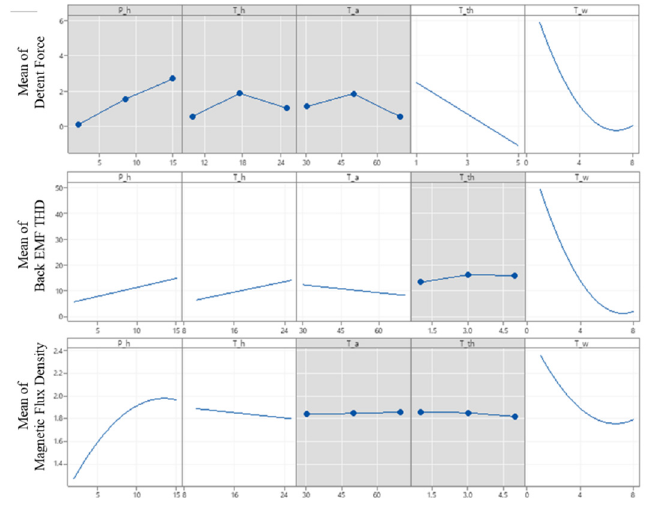
Figure 10. Main effect plot.